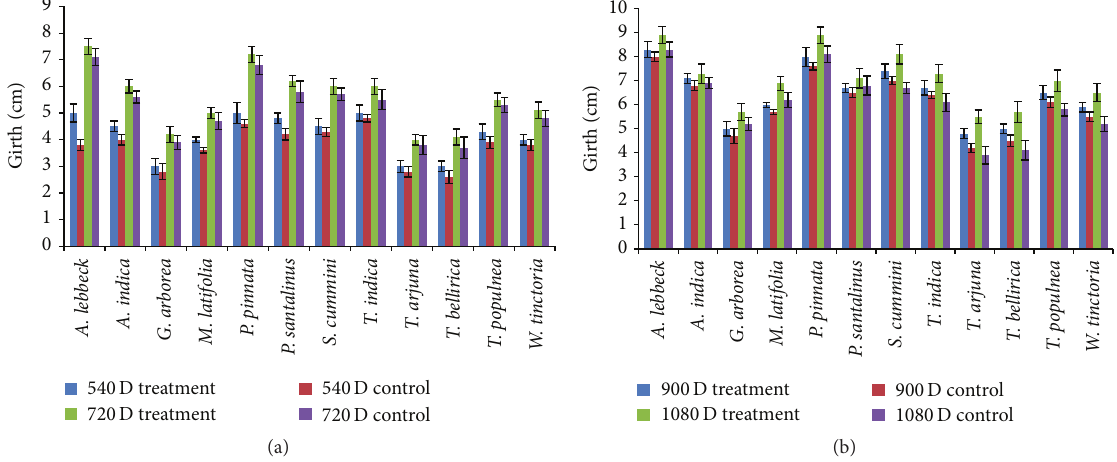
Figure 2: (a) Girth of the 12 different plant species in field experiment using application of the PGPB consortium and control for 540 days to 720 days. (b) Girth of the 12 different plant species in field experiment using application of the PGPB consortium and control for 721 days to 1080